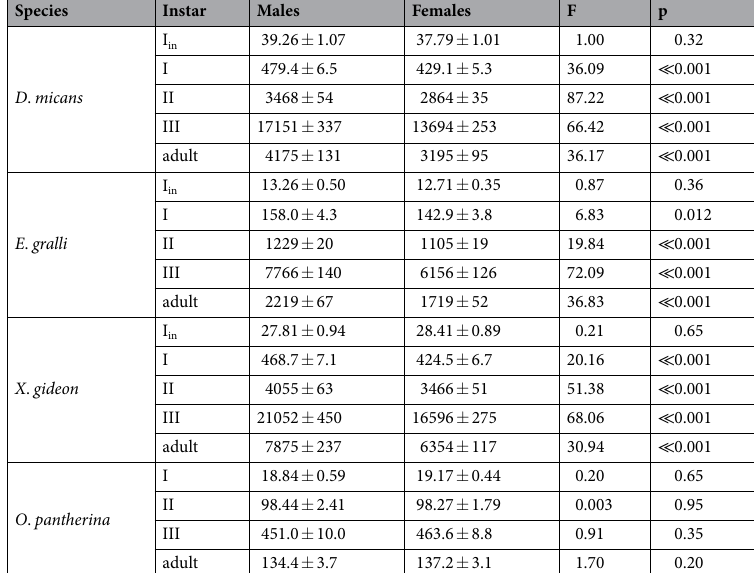
Table 2. Average maximal body mass ( ± SE) in particular developmental stages and differences between the sexes. I in refers to initial body mass (i.e. the mass at hatching). Differences between sexes were tested with a one- way ANOVA.